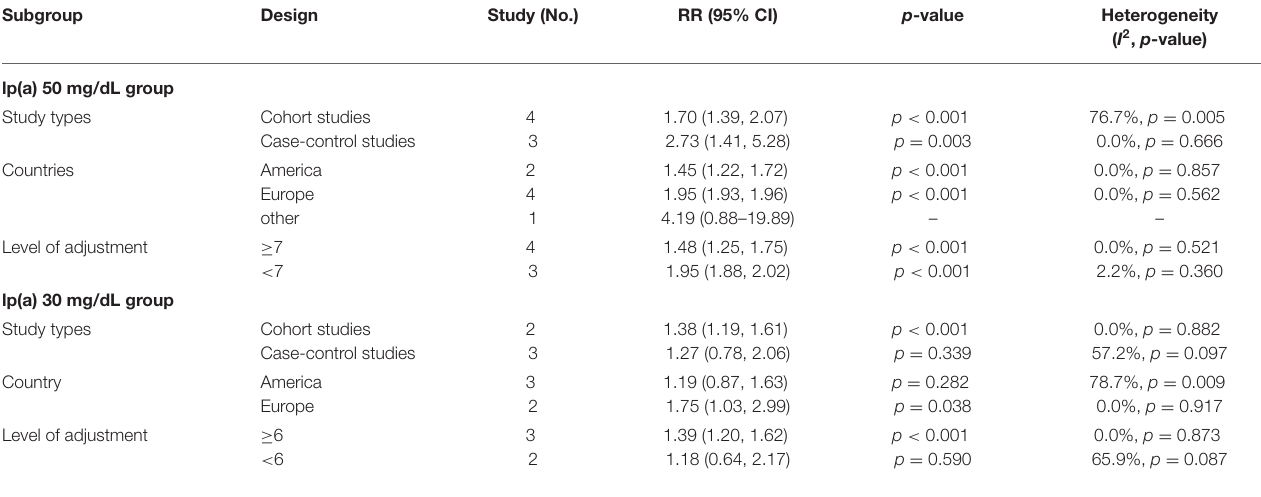
TABLE 4 | Summary risk estimates of the subgroup analyses.